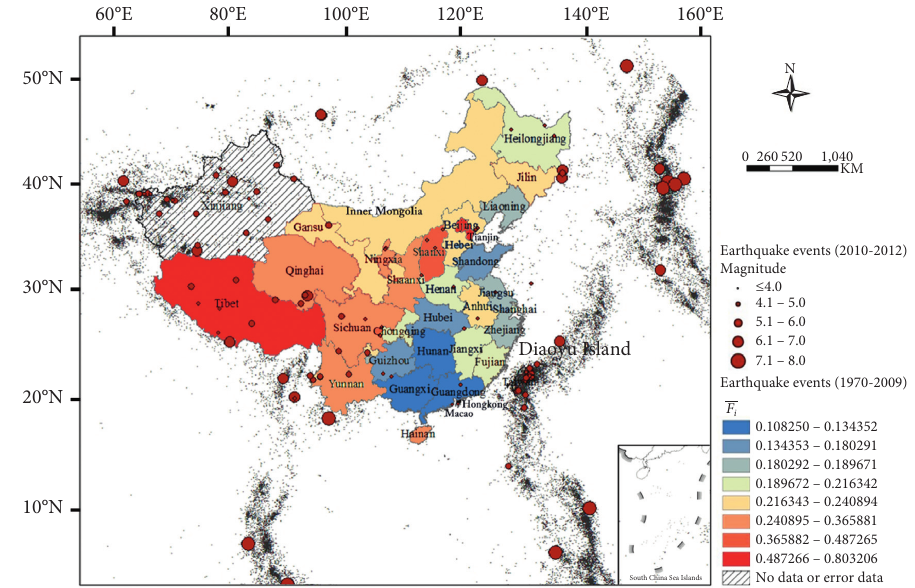
Figure 6: F and earthquake events l